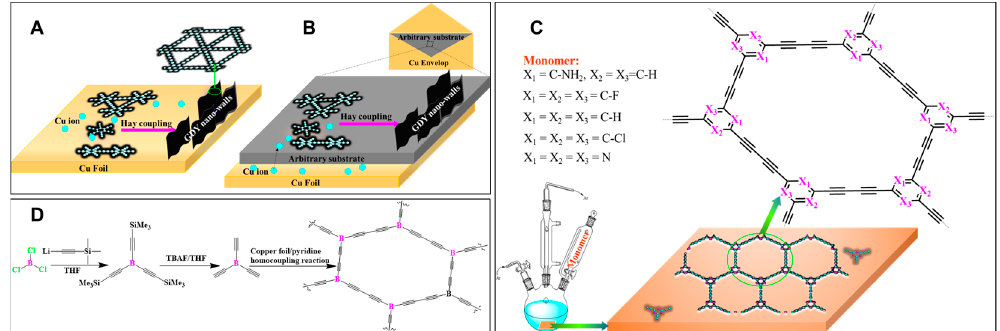
Figure 11. Proposed reaction process of GDY nanowall formation on Cu foil ( A ); envelope strategy for preparation GDY nanowalls on arbitrary substrates ( B ). Redrawn [35,106]; Glaser homocoupling reaction on Cu foil (liquid/solid method) ( C ). Redrawn [107–112]; boron-graphdiyne (B-GDY) preparation through homocoupling reaction on Cu foil (solid/liquid method) ( D ). Redrawn